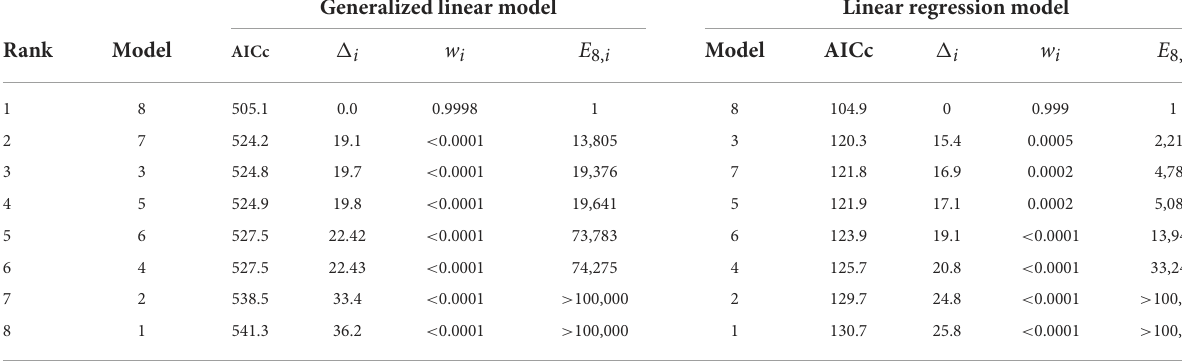
TABLE 2 Comparison of the eight different models specified in equations (1–8).